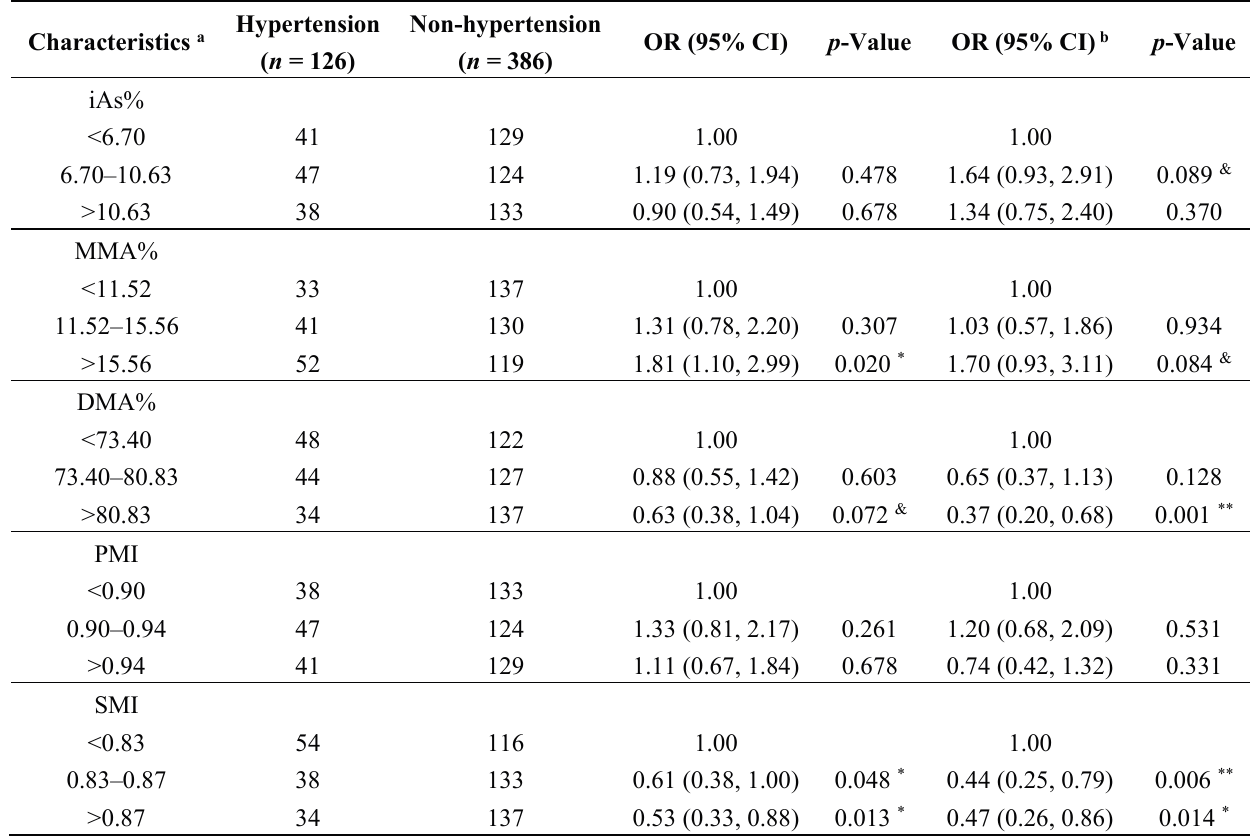
Table 2. Odd ratios (95% CIs) for association of arsenic methylation indices with the risk of hypertension among subjects from arsenic-endemic area in Inner Mongolia, China ( n =